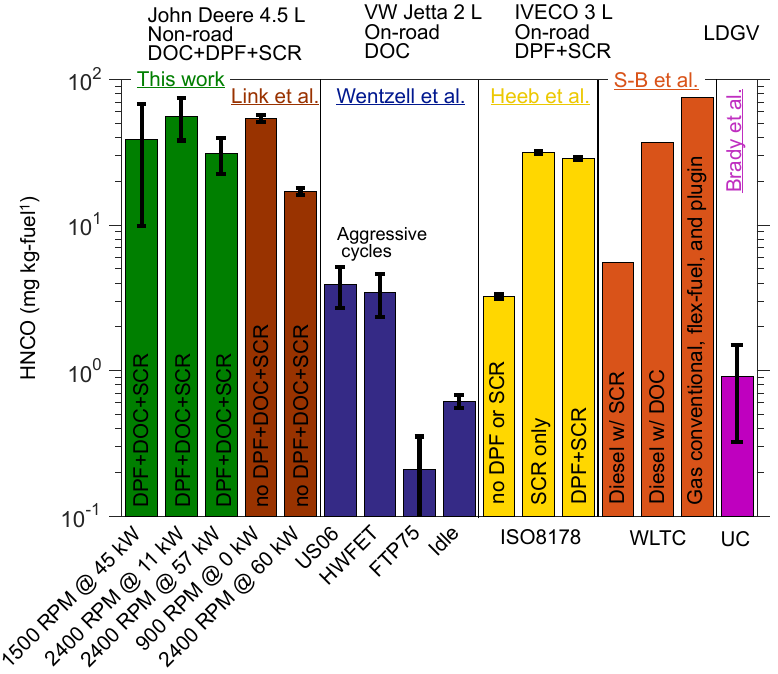
Figure 3. Emission factors for HNCO from this work compared to literature data. US06, HWFET, FTP75, ISO8178, WLTC, and UC are vehicle/engine drive cycles. S-B et al. refers to the Suarez-Bertoa and Astorga (2016)